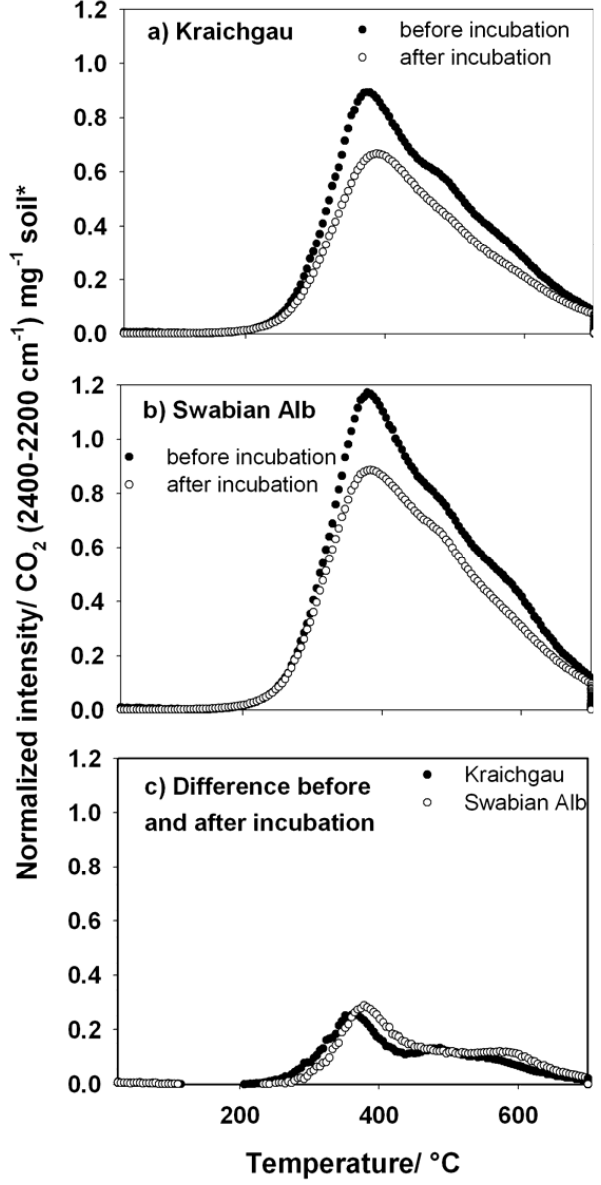
Fig. 8 Fig. 8. Effects of 490 day incubation on thermally evolved CO 2 thermogram. (A) Kraichgau soils, (B) Swabian soils, (C) difference when subtracting thermogram of soil at the end of incubation from thermogram at the beginning of the incubation. ∗ Normalized inten- sity is the integrated area of the CO 2 peak from 2400 to 2200cm − 1 normalized to weight of the